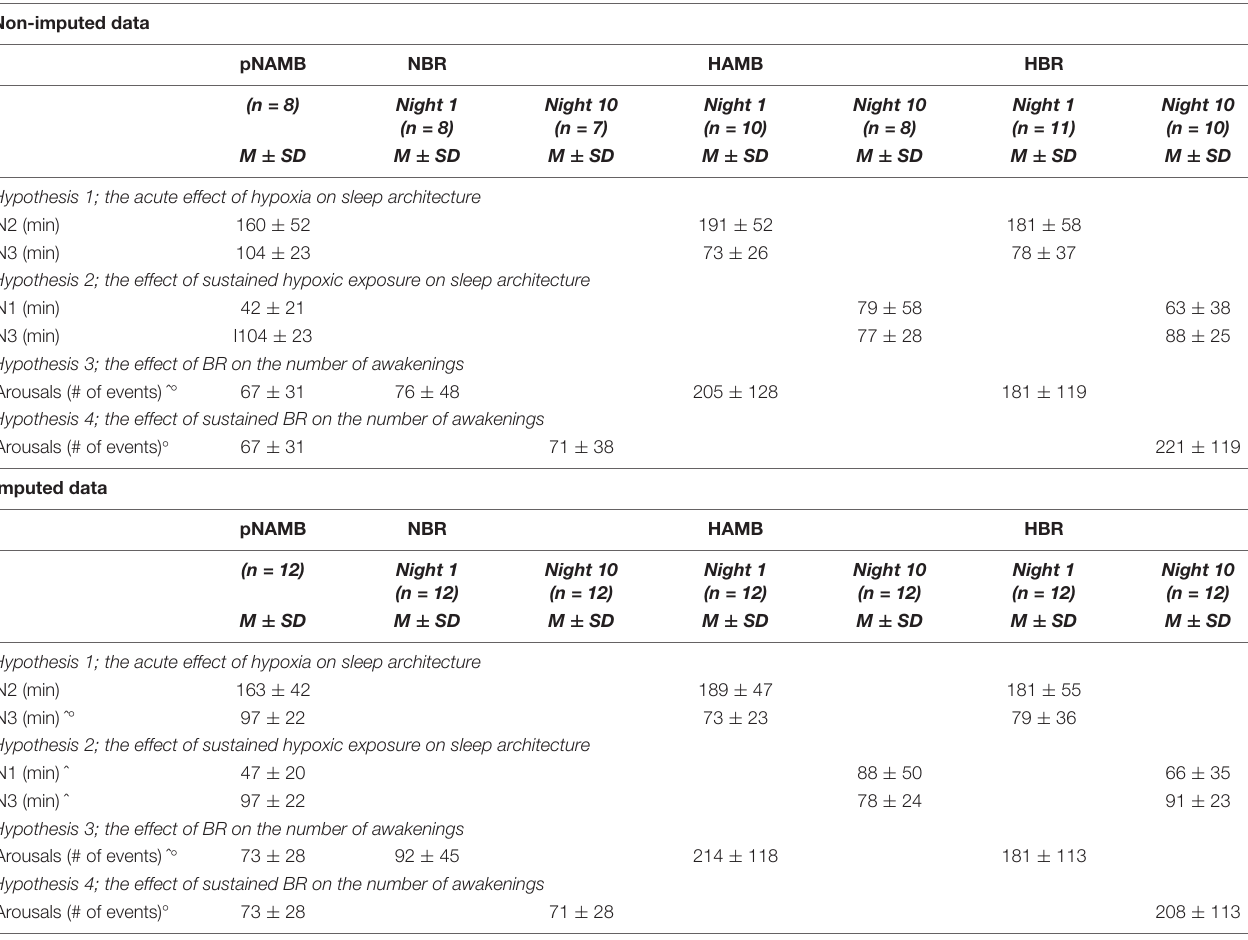
TABLE 6 | Overview of all polysomnography-related data required to evaluate the pre-defined hypotheses that were based on the reported results in the study of Rojc et al.